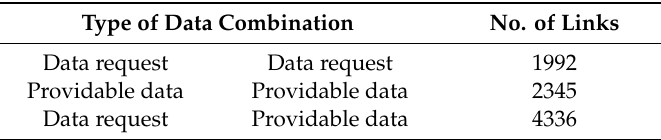
Table 4. Number of links by data